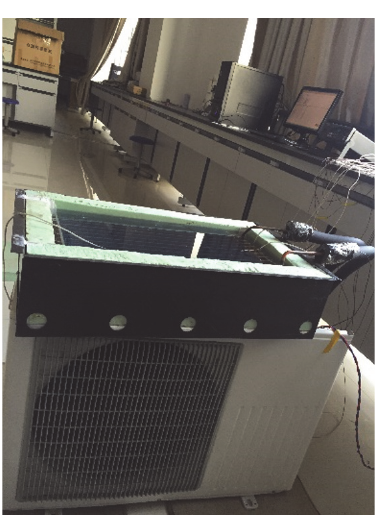
Figure 18: The photo of evaporator immersion static ice maker.